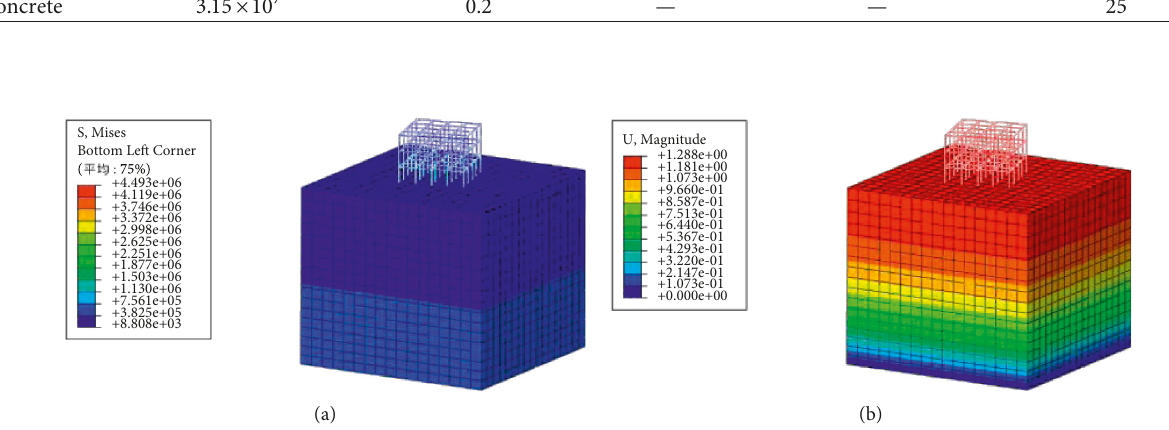
Figure 2: Calculated results of static analysis of the stratum-structural model. (a) Stress nephogram. (b) Displacement nephogram.